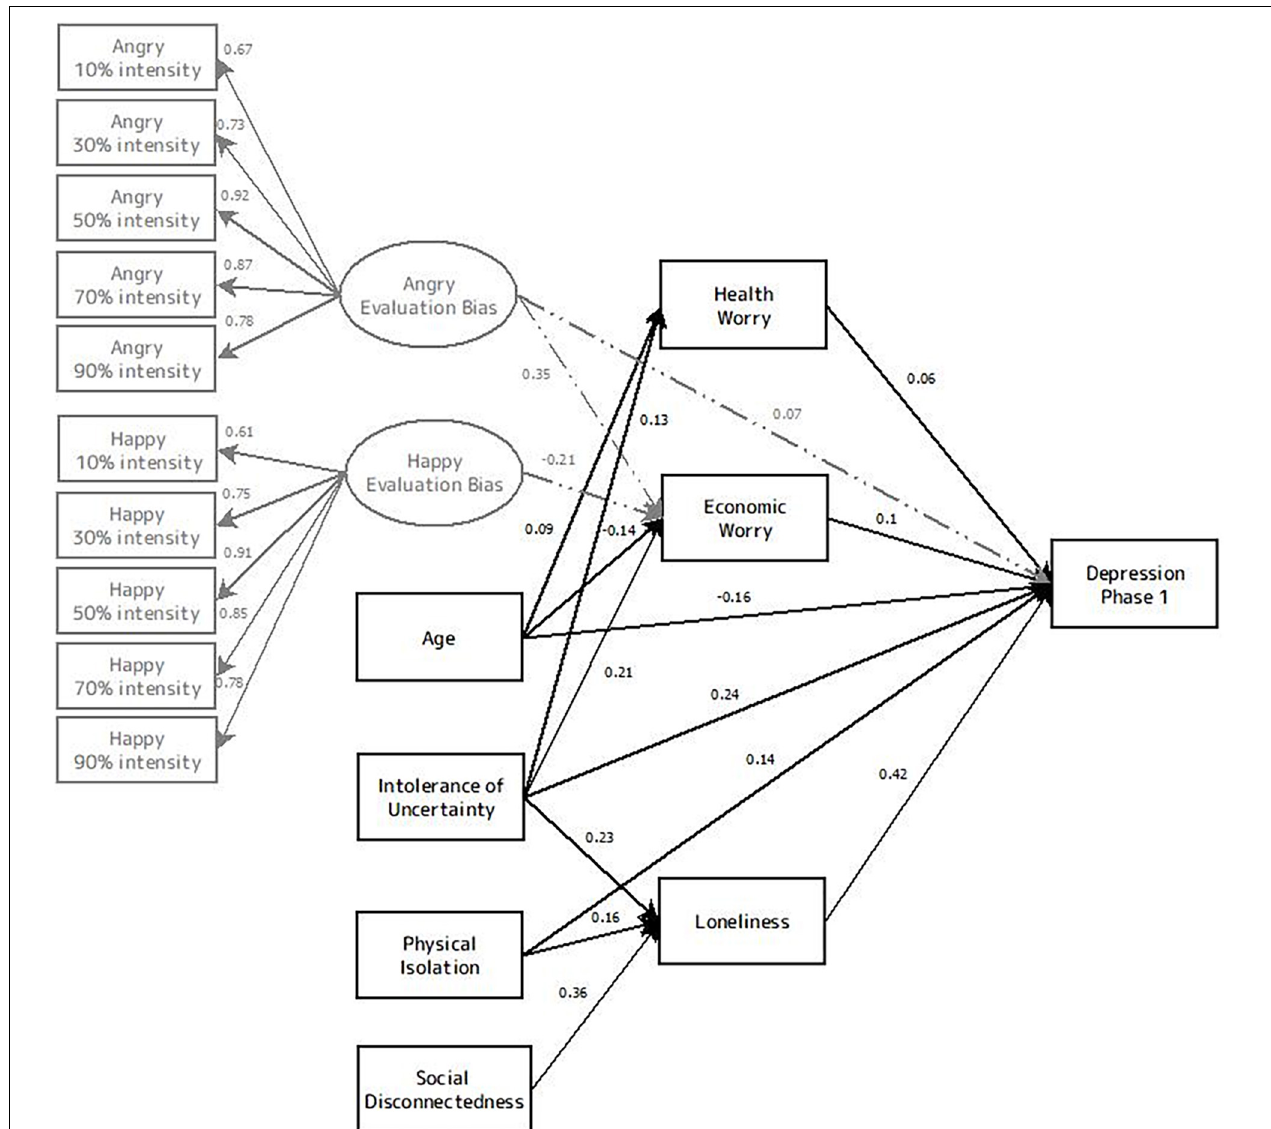
FIGURE 2 | Model of the relationships among age, economic worry, health worry, physical isolation, social disconnectedness, loneliness, intolerance of uncertainty, emotional evaluation bias and symptoms of depression in phase 1. Black lines represent connections in the best fitted model. Gray lines represent non-significant connections that are not included in the best model. Rectangles represent observed variables, and ovals represent unobserved variables. Solid lines represent connections in the best fitted model, and dashed lines represent significant connections that are not included in the best model. Values embedded in unidirectional arrows are standardized regression